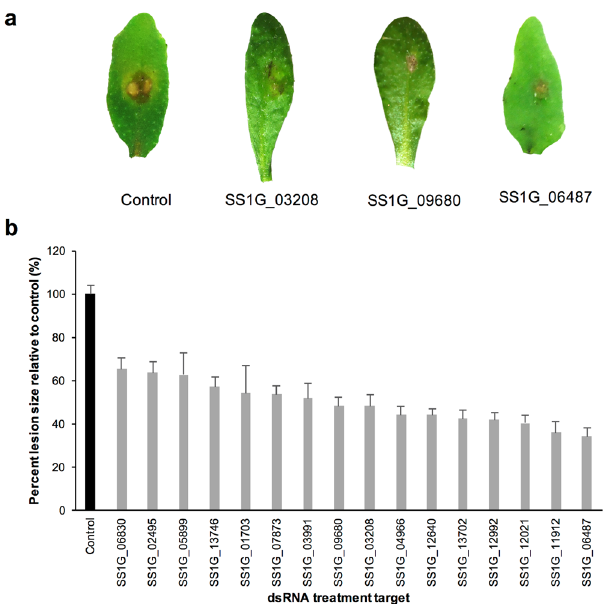
Figure 6. DsRNA treatment on A . thalaina leaves reduces S . sclerotiorum lesion area. ( a ) S . sclerotiorum spore inoculation on A . thaliana leaves after a foliar application 200 ng of specific dsRNA spread over the entire leaf surface at 4 dpi. ( b ) Average lesion relative to control (darker bar) with standard error bars of 3 bioreps of 10 leaves (n = 30). All targeting dsRNA treatment were significantly different from control (student’s t-test with Bonferroni correction, p < 0.0031).